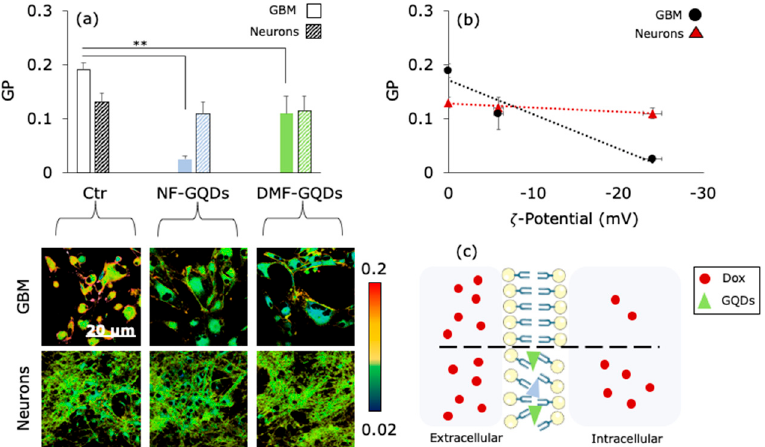
Figure 3. Synergistic mechanism of GQDs and chemotherapy. GP values of GBM and neurons, obtained with Laurdan confocal imaging, show an increase in membrane permeability after the treatment with GQDs ( a ). In the inset, representative images obtained with confocal microscopy. The correlation between the surface net charge of GQDs and GP on GBM ( b ). The proposed mechanism for GQDs enhanced chemotherapy ( c ). ** p < 0.01, one-way ANOVA and Turkey post-hoc